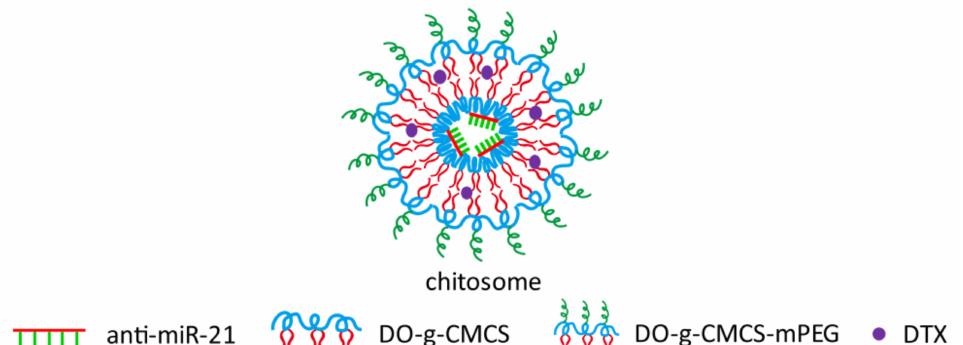
Figure 9. Chitosome outline containing anti-miRNA-21, dioleoyl grafted carboxymethyl CS (DO- g-CMCS), PEGylated dioleoyl grafted carboxymethyl CS (DO-g-CMCS-mPEG), docetaxel (DTX). Reprinted with permission from ref. [65]. Copyright 2020 Drug Deliv. Transl.